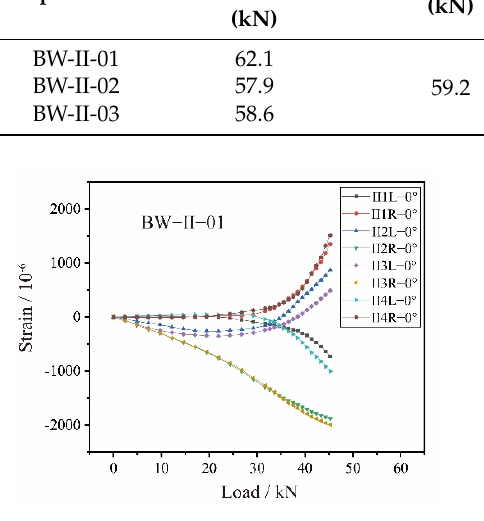
Figure 10. The strain-load curves of different measurement points in the web region of the BW-II-01 specimen.